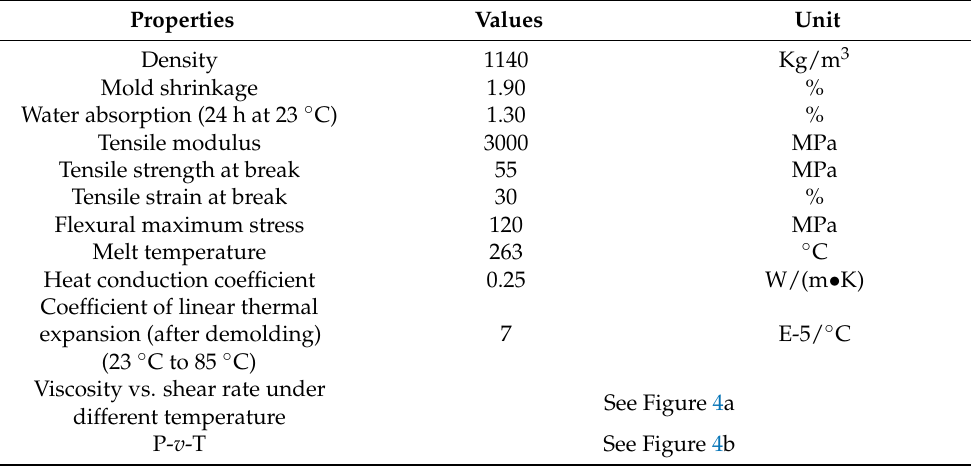
Table 1. Material properties of PA66 (TECHNYL A 216, Solvay Engineering Plastics; Source: Moldex3D material